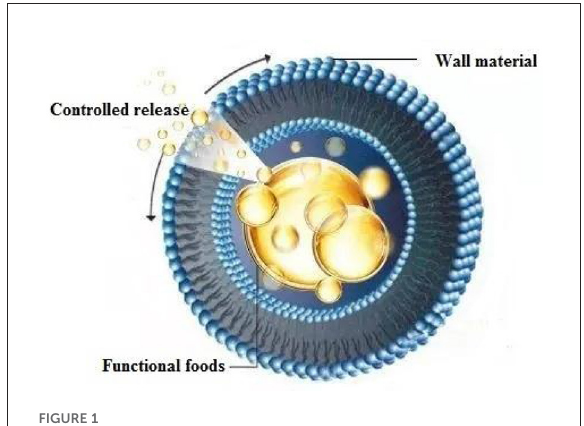
FIGURE1 Schematic diagram of nano-microcapsule controlled release